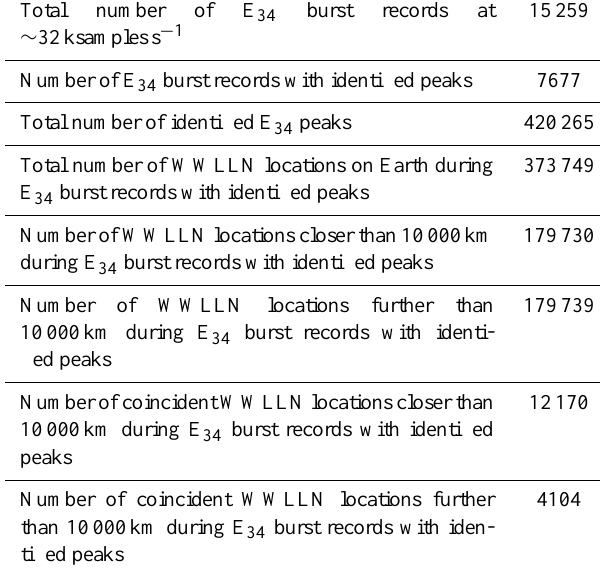
Table 1. Statistical database from 4 November 2008 through 30 November 2010.